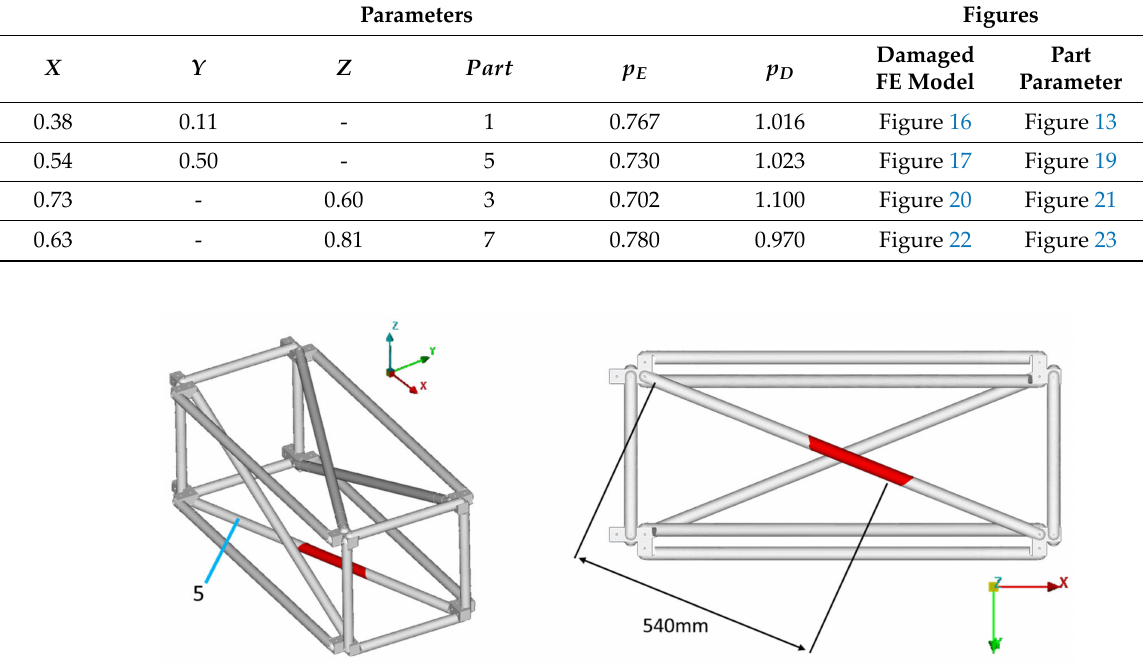
Figure 17. D5: Damaged FE model.